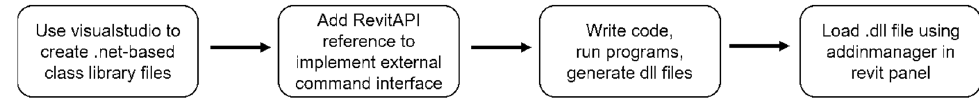
Figure 1. Basic process of Revit secondary development.